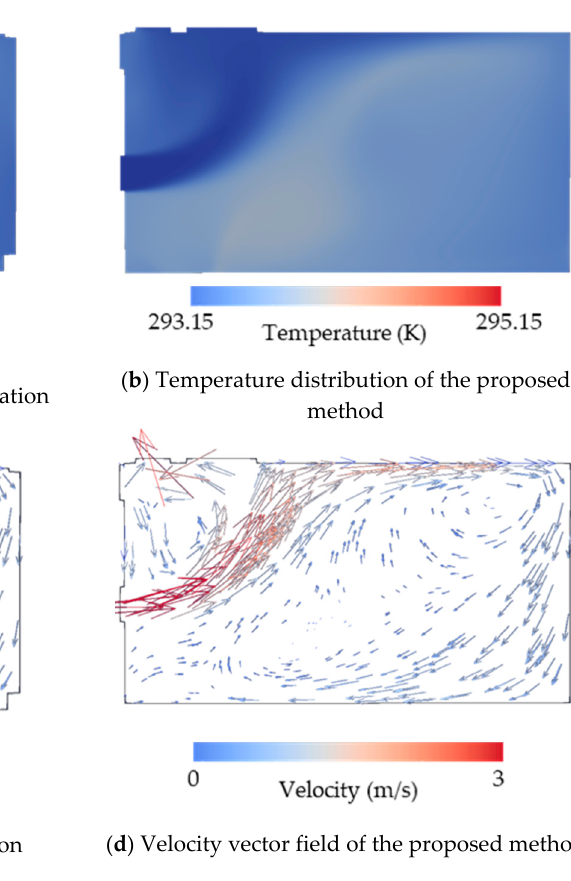
Figure 9. Difference in temperature distribution and vector filed at B-type according to optimization. Table 8. Evaluation of reduction in working time for optimal CFD model